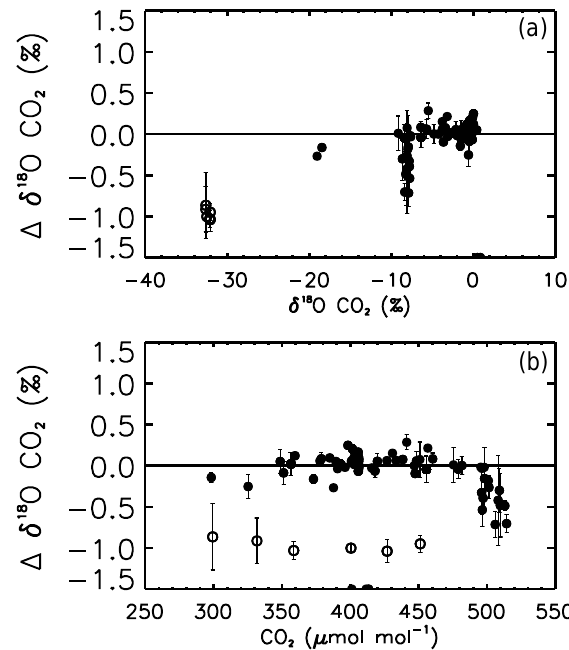
Figure 4. The same as Fig. 3 (a, b) but for δ 18 O. INSTAAR un- certainties are typically ± 0.05‰ (68% CI) (Trolier et al., 1996) but again do not account for problems with the collection of the discrete air samples. Differences greater than 1.5‰ are assumed to be caused by problems during discrete sample collection. These re- sults are shown but are not included in the statistics. Highly depleted cylinders ( δ 18 O< − 20‰) are shown with open